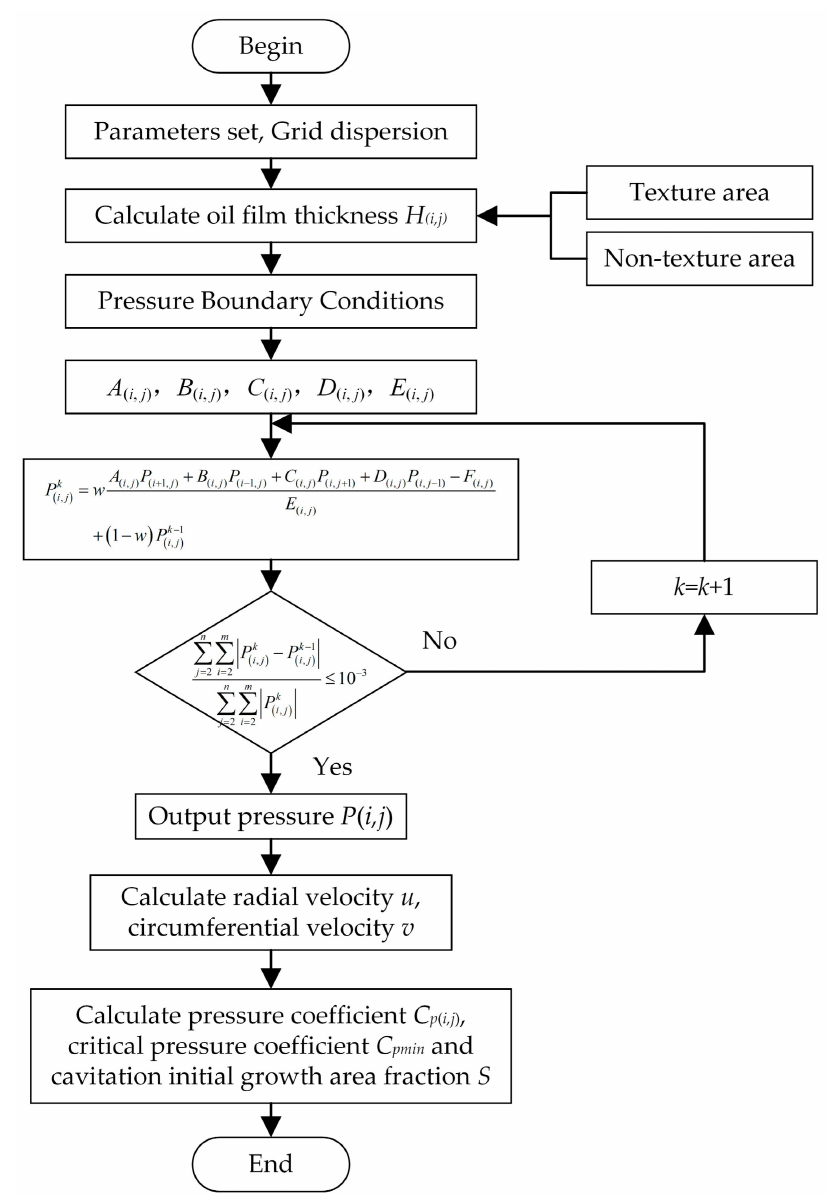
Figure 6. Flowchart of finite difference algorithm for Reynolds